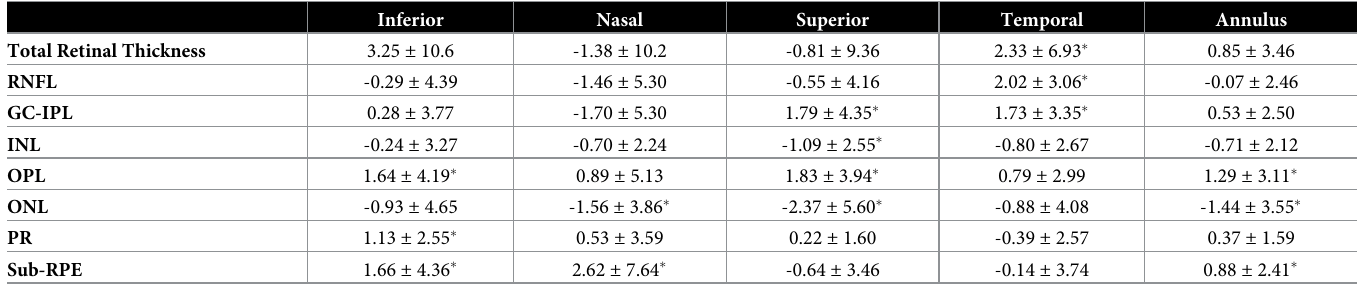
Table 2. Mean difference ± standard deviation in thickness between baseline and post-treatment macular